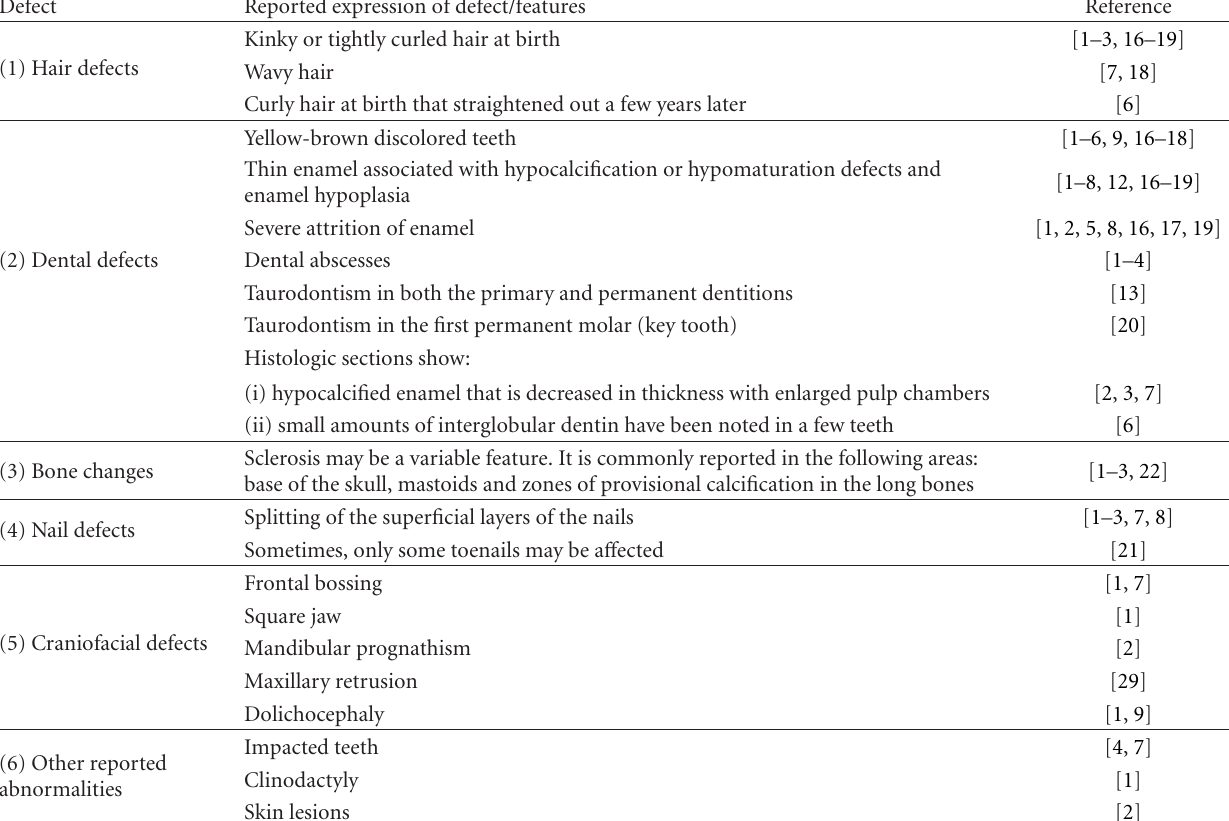
Table 1: Characteristic defects in